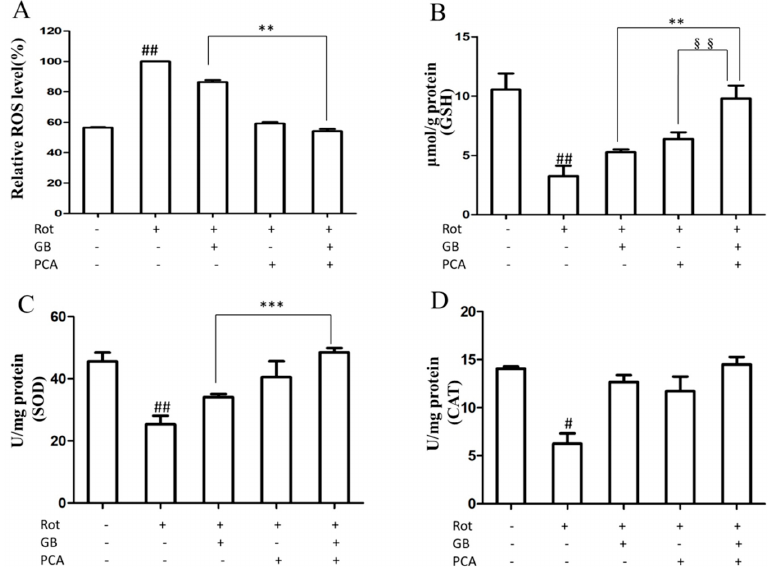
Figure 3. The combined effects of GB and PCA on the oxidative stress in Rot-induced PC12 cells. ( A ) The combined effects of PCA and GB on the Rot-induced formation of reactive oxygen species (ROS) in PC12 cells. ( B – D ) The combined effect of PCA and GB on the activities of GSH, SOD, and CAT in Rot-induced PC12 cells. Rot-induced PC12 cells were treated for 48 h with 25 μ M GB or 0.6 mM PCA alone or in combination at the specified concentration. The data represent the means ± SDs of three independent experiments. # p < 0.05 and ## p < 0.01 vs. the normal group, ** p < 0.01 and *** p < 0.001 vs. the GB-treated group. §§ p < 0.01 vs. the PCA-treated group.